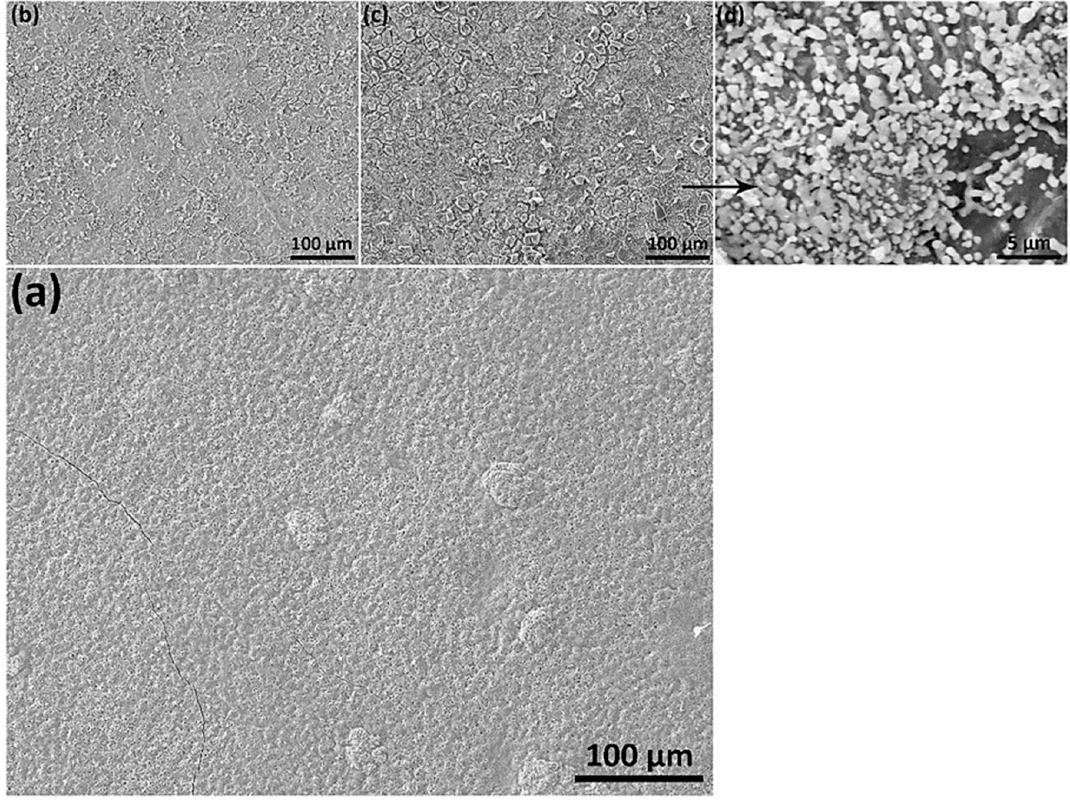
Figure 4. SEM micrographs of TiSiNb 0.02 TFSOC: ( a ) annealed at 500 °C, ( b ) 600 °C and ( c , d ) 700 °C in N 2 atmosphere.